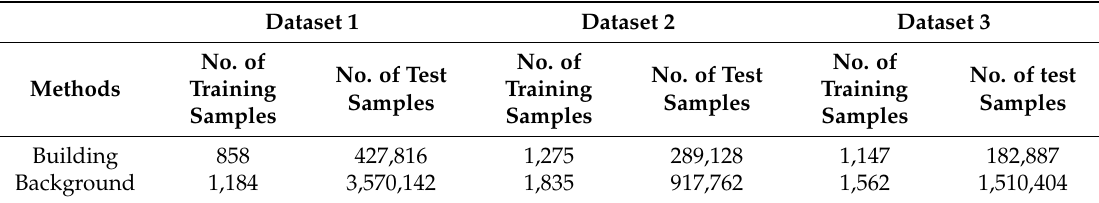
Table 3. Training and test samples for the three